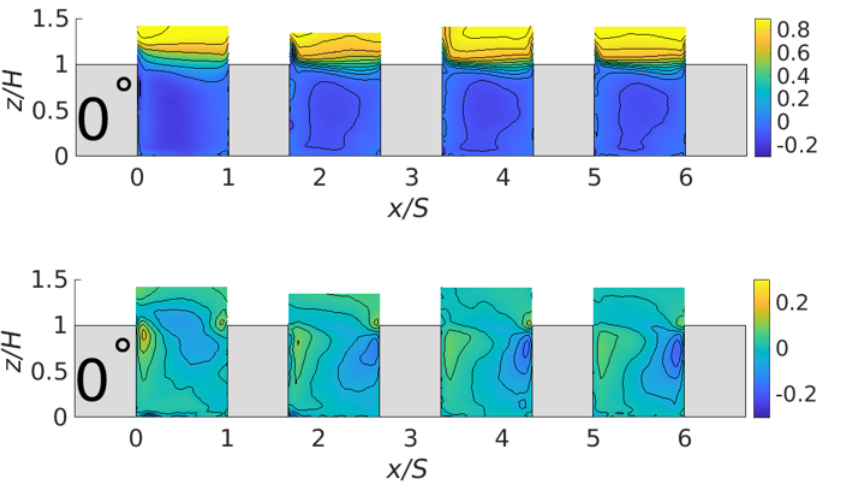
Figure 6. (Top) Non-dimensional mean streamwise velocity U / U H and (bottom) mean wall-normal velocity W / U H at y / W b = 0. Data extracted from the experiments by Monnier et al. [9]. Note that S denotes street separation.